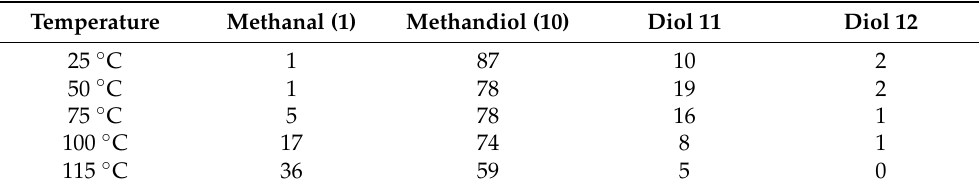
Table 2. The molar ratios of selected compounds at various temperatures for paraformaldehyde and water in DMSO- d 6 . Temperature